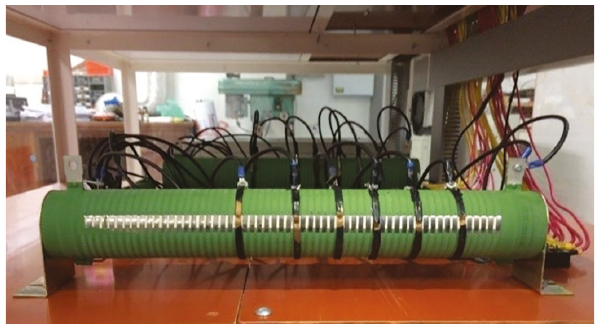
Figure 9: Resistors of the HVDC transmission line.